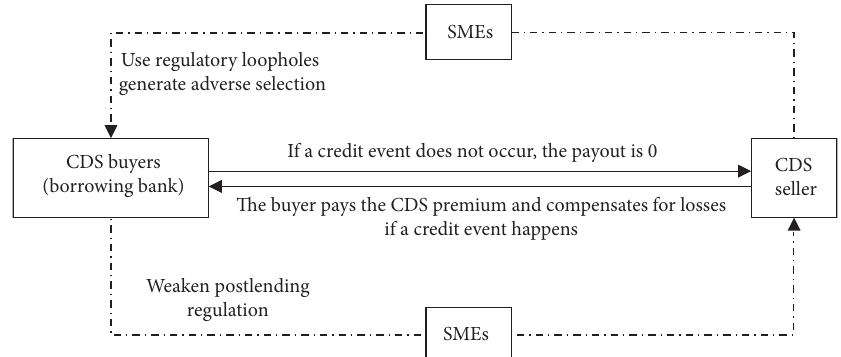
Figure 1: Credit financing mechanism of SMEs under the influence of